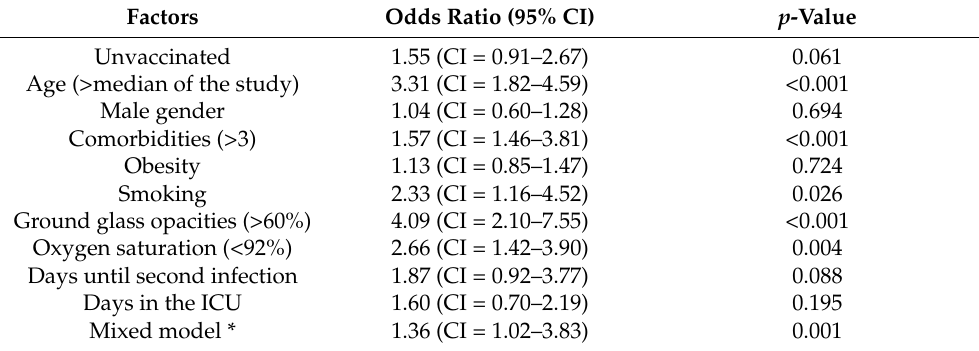
Table 3. Risk factors associated with severe illness and mortality among breakthrough cases and reinfection cases in unvaccinated